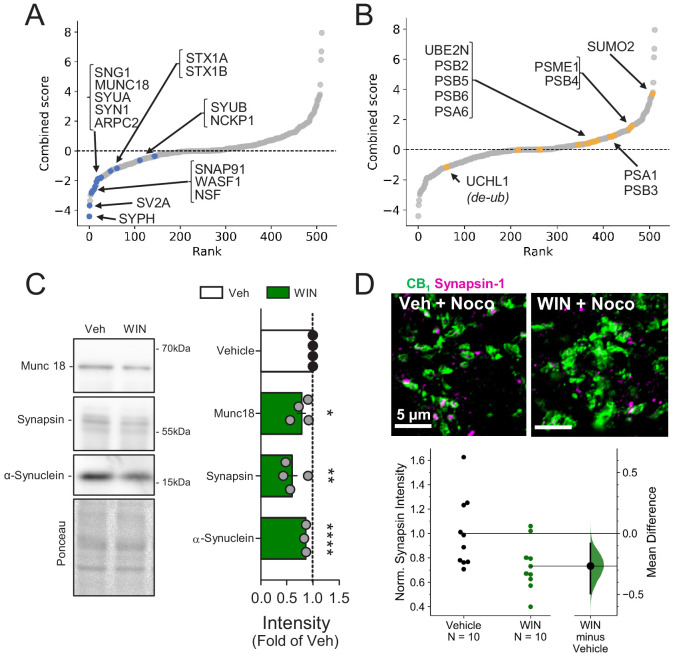
Presynaptic proteins are rapidly reduced following CB1 activation.(A) Combined score plot of differentially expressed proteins between vehicle vs. CB1 activation with WIN. Blue dots are manually selected presynaptic cytomatrix and release machinery proteins. SYPH: Synaptophysin; SV2A: Synaptic vesicle glycoprotein 2A; Synaptosome associated protein 91: SNAP91; WASF1: Wiskott-Aldrich syndrome protein family member 1; NSF: Vesicle-fusing ATPase; SNG1: synaptogyrin; MUNC18: mammalian homologue of UNC-18; SYUA: alpha-synuclein; SYN1: Synapsin-1; ARPC2: Arp complex subunit 2; STX1A-B: Syntaxin1A-1B; SYUB: beta-synuclein; NCKP1: Nck-associated protein 1. (B) Combined score plot of differentially expressed proteins between vehicle vs. CB1 activation with WIN. Yellow dots are manually selected ubibquitin-proteasome system-related proteins. Note that the only downregulated protein is a de-ubiquitinase. UCHL1: Ubiquitin carboxyl-terminal hydrolase isozyme L1; PSB 2,3,4,5,6: Proteasome subunit beta type-2,4,5,6; PSA 1,6: Proteasome subunit alpha type 1,6; SUMO2: Small ubiquitin-related modifier 2; PSME1: Proteasome activator complex subunit 1. (C) Left, representative Western blot images of staining for presynaptic proteins Munc18-1, Synapsin-1, and α-Synuclein and Ponceau loading control in vehicle vs. WIN-treated hippocampal cultures (5 µM, 25 min). Right, quantification of three experimental replicates normalized to Vehicle revealed a decrease in all three proteins consistent with SILAC. Munc18-1: 0.78 ± 0.09, p<0.05; Synapsin-1: 0.60 ± 0.11, p<0.01; α-Synuclein: 0.86 ± 0.01, p<0.0001, unpaired t-test, n = number of cultures. (D) Top, Airyscan confocal representative images of CB1+ boutons in acute hippocampal slices in CA1 pyramidal layer showing colocalization of CB1+ boutons (green) and Synapsin-1 (magenta). Bottom, Gardner-Altman estimation plot showing the mean difference between Control and WIN of intensity of Synapsin-1 puncta within CB1+ boutons per slice was significantly diminished by WIN application (5 µM, 25 min). Both groups are plotted on the left axes; the mean difference is plotted on a floating axes on the right as a bootstrap sampling distribution. The mean difference is depicted as a dot; the 95% confidence interval is indicated by the ends of the vertical error bar. Control: 1.0 ± 0.09, WIN: 0.73 ± 0.06 (Mean ± S.E.M.), n = number of slices (10 slices, four rats/condition). The unpaired mean difference between Control and WIN is −0.267 [95.0%CI −0.494, −0.0819]. Two-sided permutation t-test, p=0.0234.